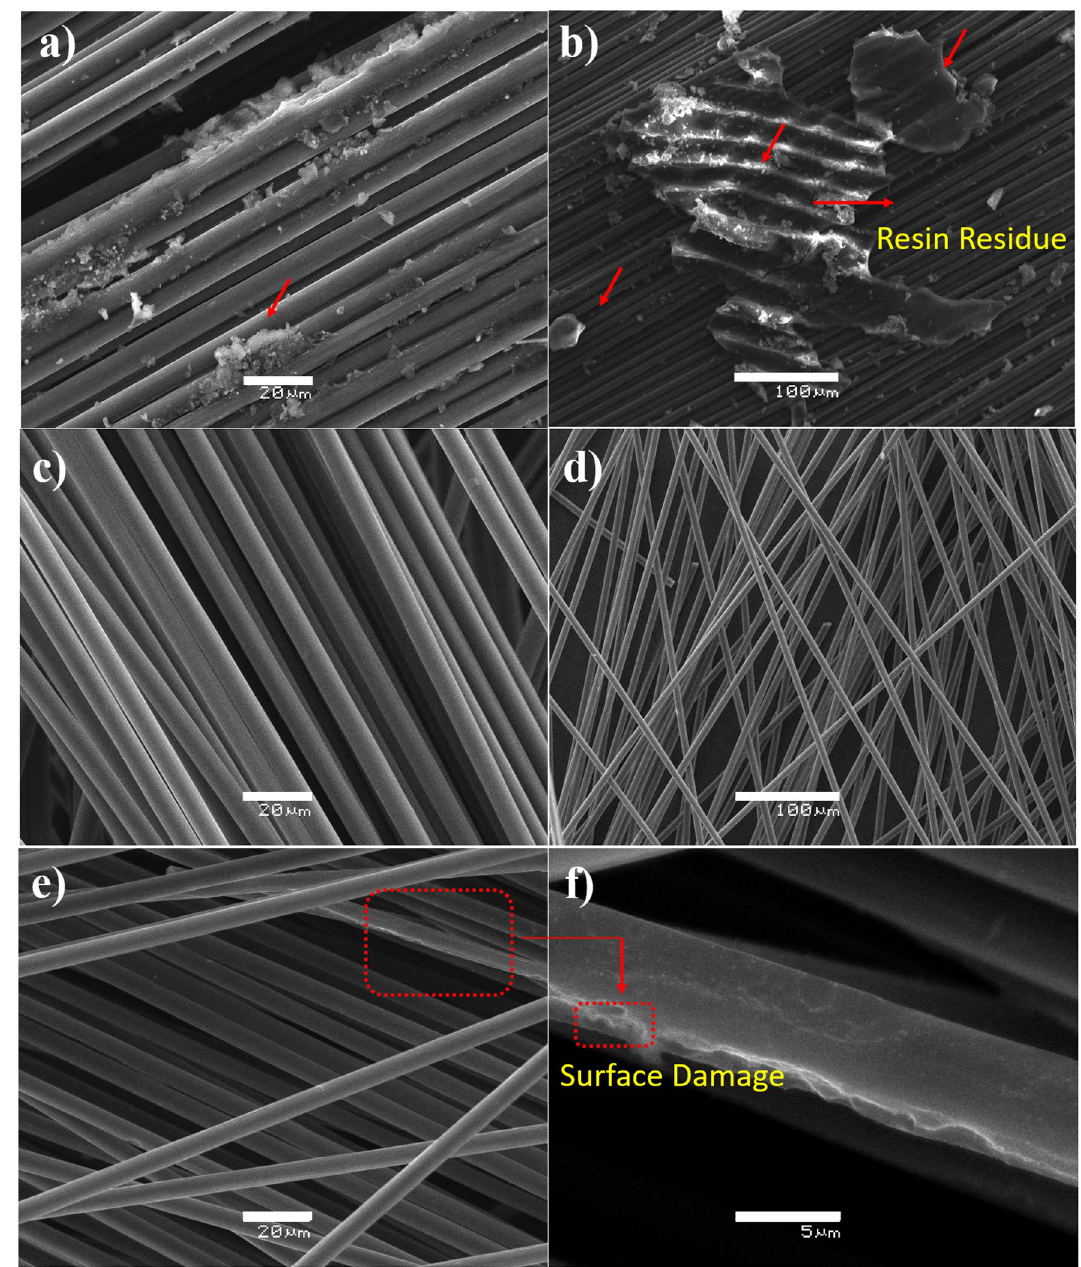
Figure 2. SEM images of CFs recycled by thermolysis ( a , b ) until obtaining vapours (onset of matrix decomposition at 350 °C) showing resin residues on its surface, up to 500 °C ( c , d ) and 700 °C ( e , f